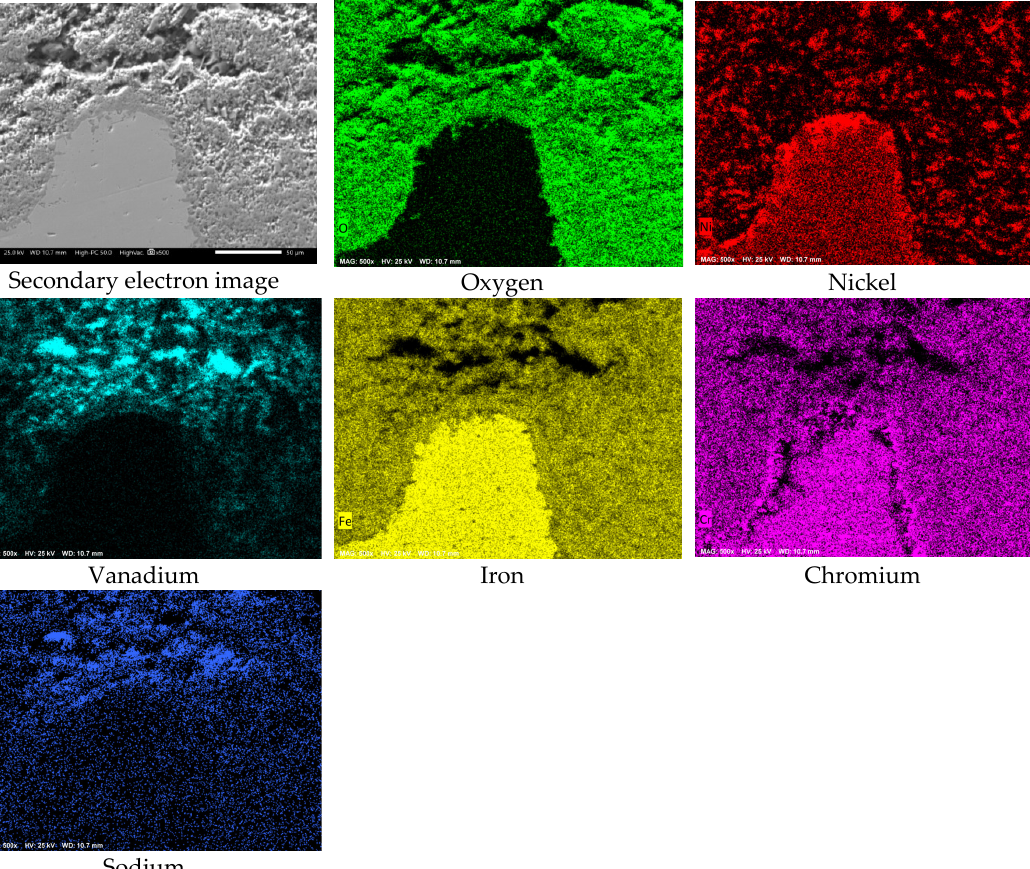
Figure 8. Cross-sectional aspect and element mapping of the 304H steel interface corroded in NaVO 3 at 900 °C after 100 h.